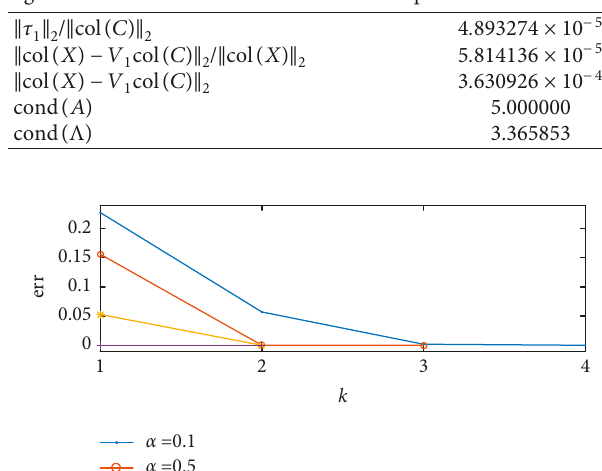
Table 1: L norm of the errors obtained by predictor-corrector 2 algorithm and condition numbers for Example 1.